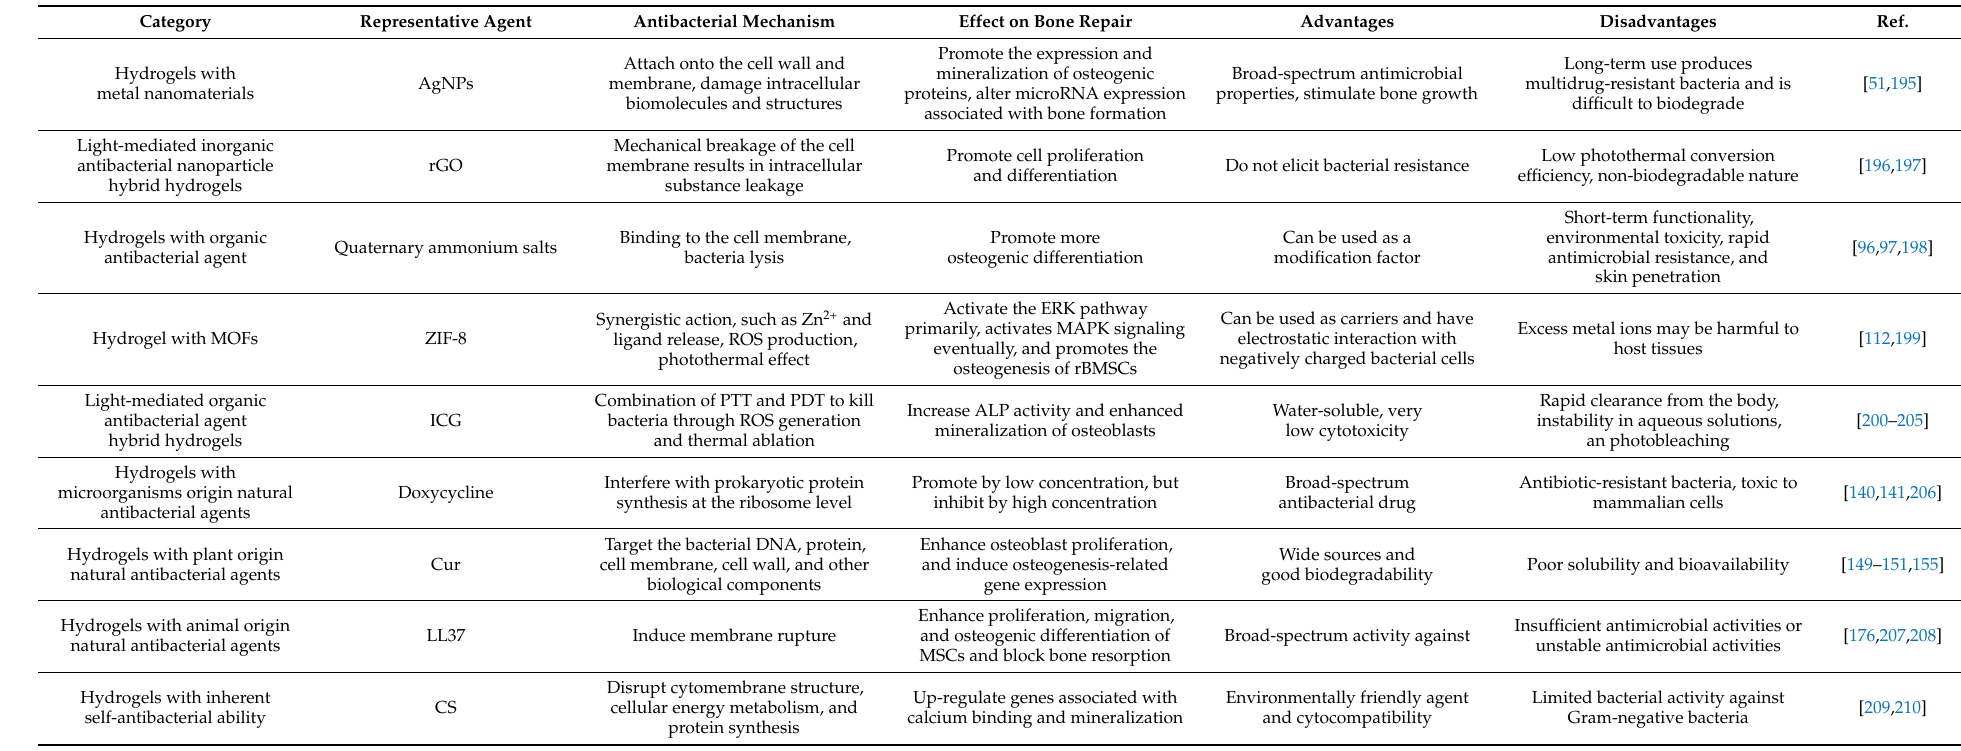
Table 1. Summary of different antibacterial agents hybrid hydrogels for infected bone